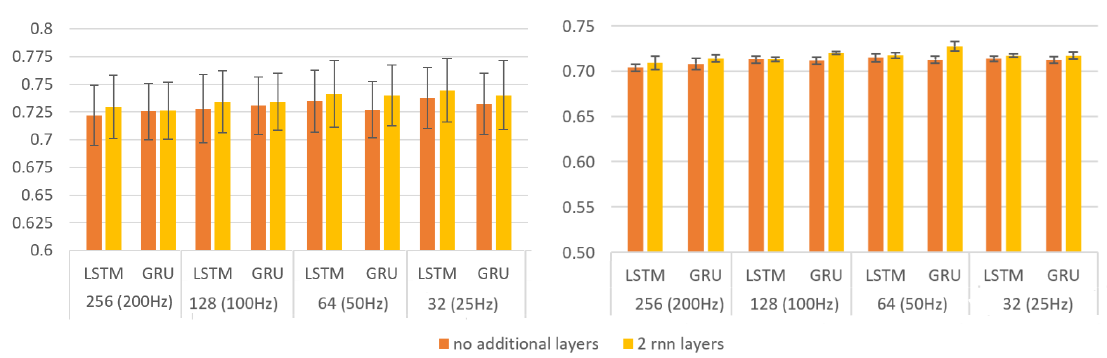
Figure 4. Macro F1-score results for each architecture and different input width (frequency sampling). On the left: The results applying 10-fold cross validation with the training subset. On the right: Results with the training subset and evaluated with the test subset (average results from training five times each